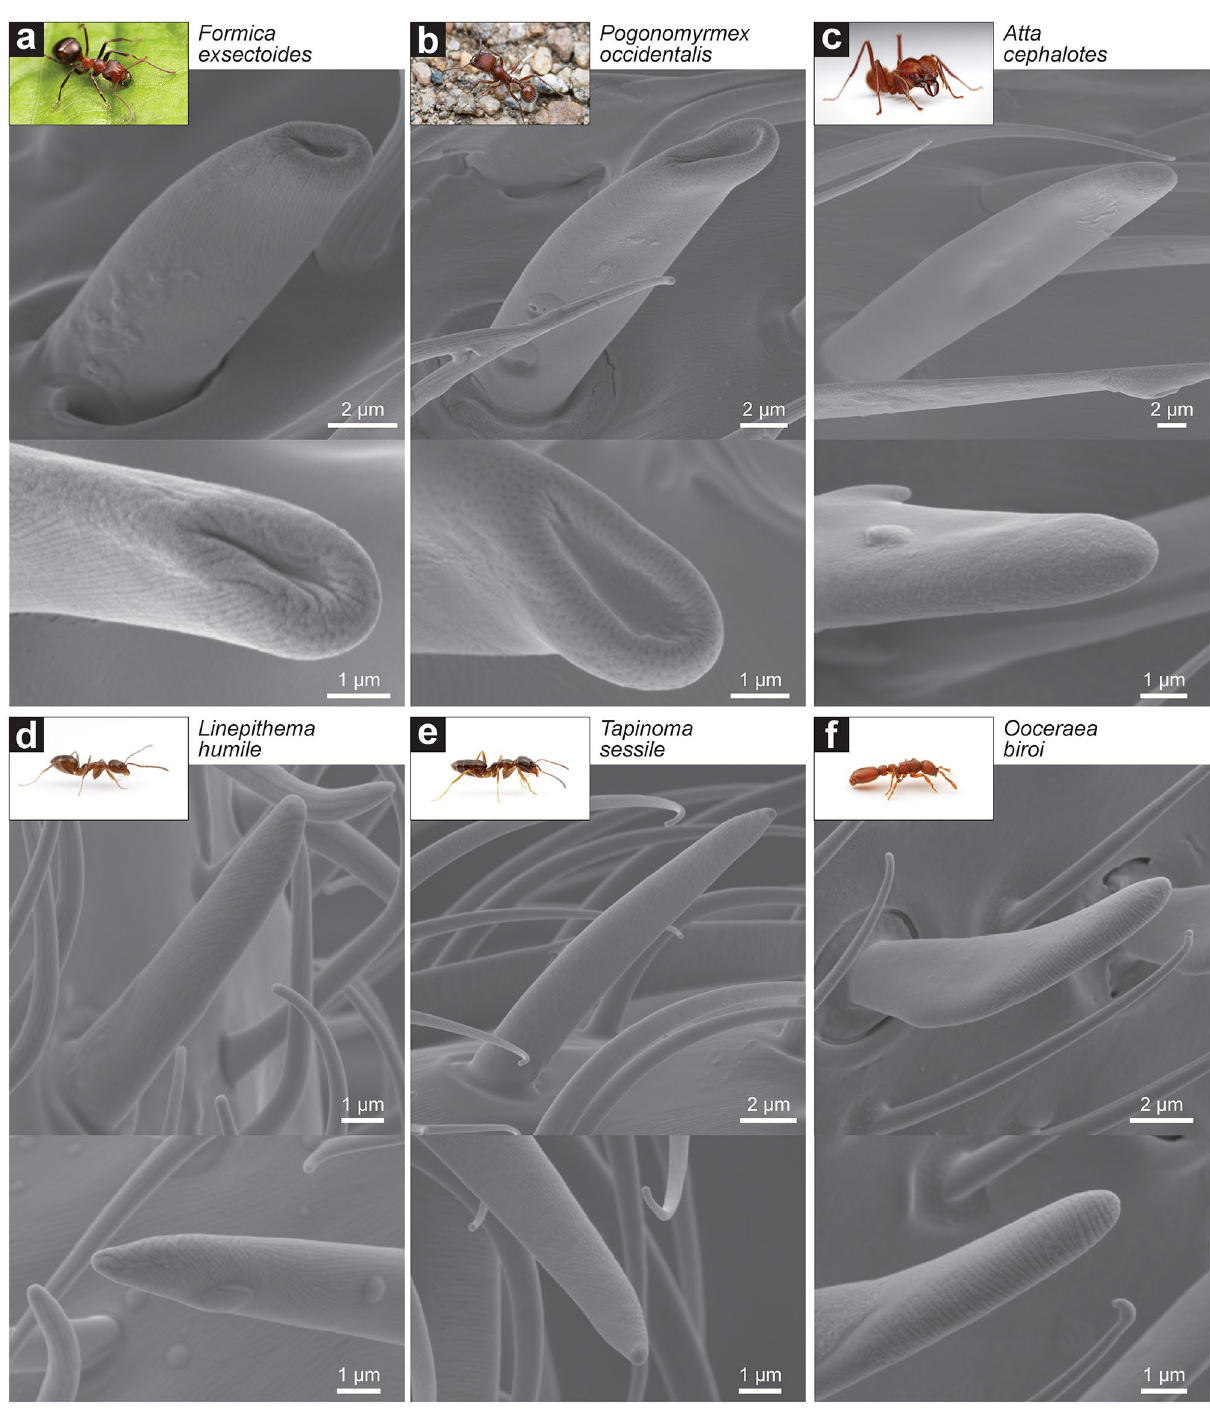
Figure 3. Basiconic sensillum morphology across major subfamilies of ants. Images of both the basiconic sensillum (top) and its tip (bottom) of ( a ) Formica exsectoides worker (subfamily Formicinae), ( b ) Pogonomyrmex occidentalis worker (subfamily Myrmicinae), ( c ) Atta cephalotes super major (subfamily Myrmicinae), ( d ) Linepithema humile worker (subfamily Dolichoderinae), ( e ) Tapinoma sessile worker (subfamily Dolichoderinae), and ( f ) Ooceraea biroi (subfamily Dorylinae). Inset ant images are provided courtesy of Alex Wild